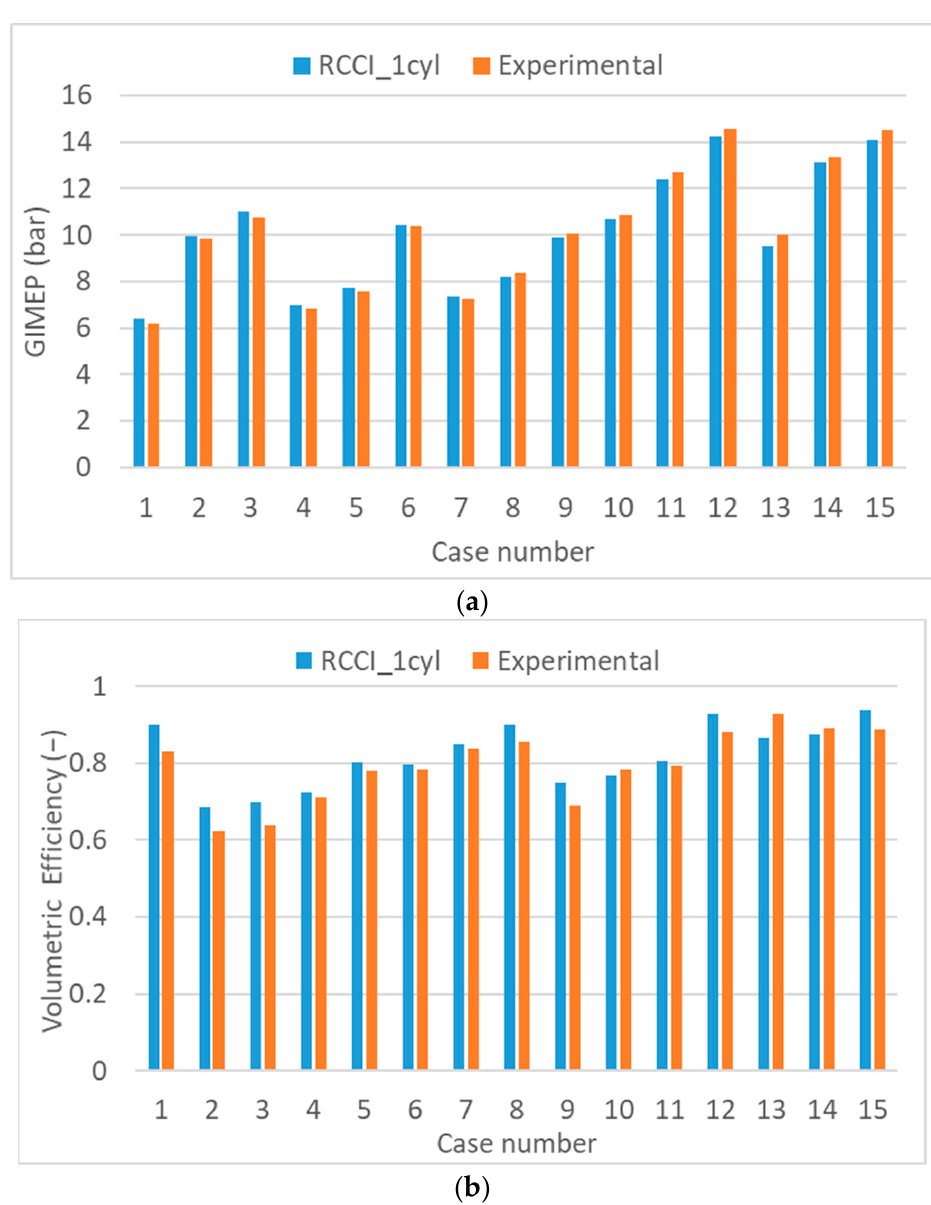
Figure 4. Gross IMEP ( a ) and volumetric efficiency ( b ): comparison between the calibrated 1D model and the experimental data.